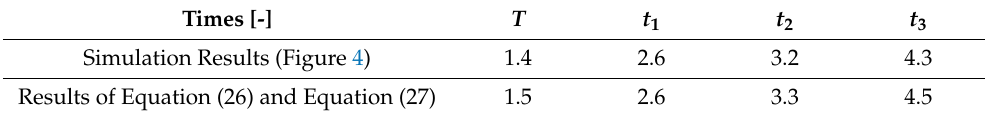
Table 3. Comparison between the simulation and analytical results for the case of the two bubbles. Times [-] T t 1 t 2 Simulation Results (Figure 4)